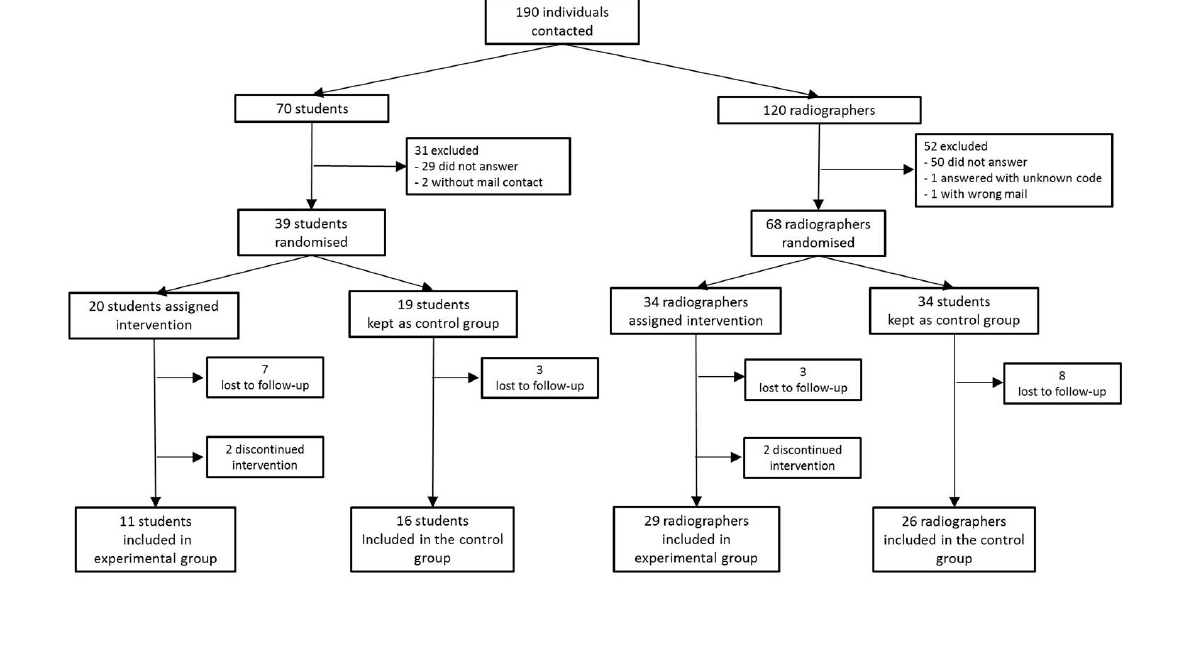
Figure 6. Participant flow diagram showing enrolled sample and respective dropouts. Individuals who did not answer the participation request